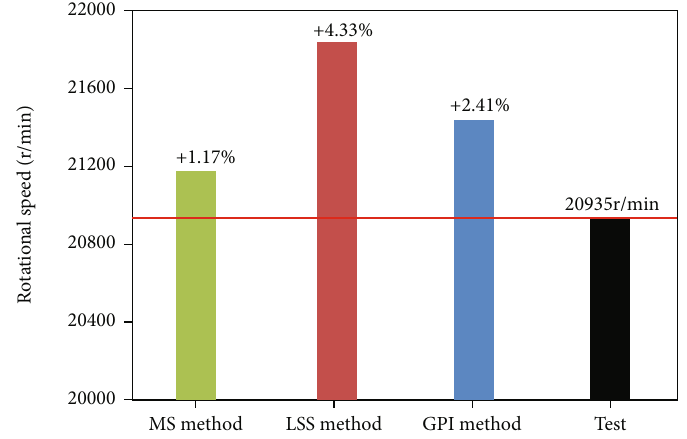
Figure 16: Burst speed